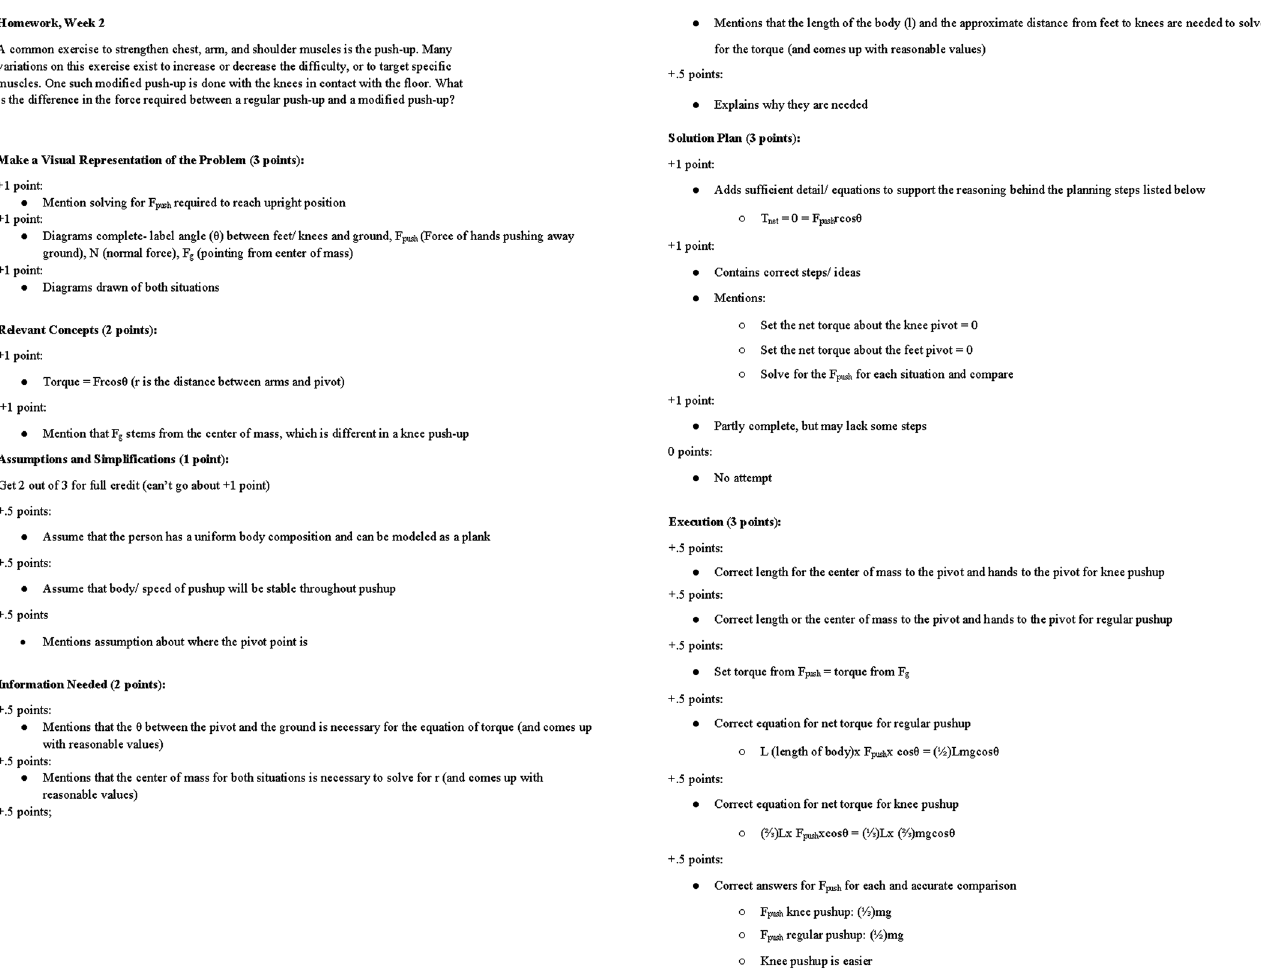
FIG. 11. Rubric for homework, week